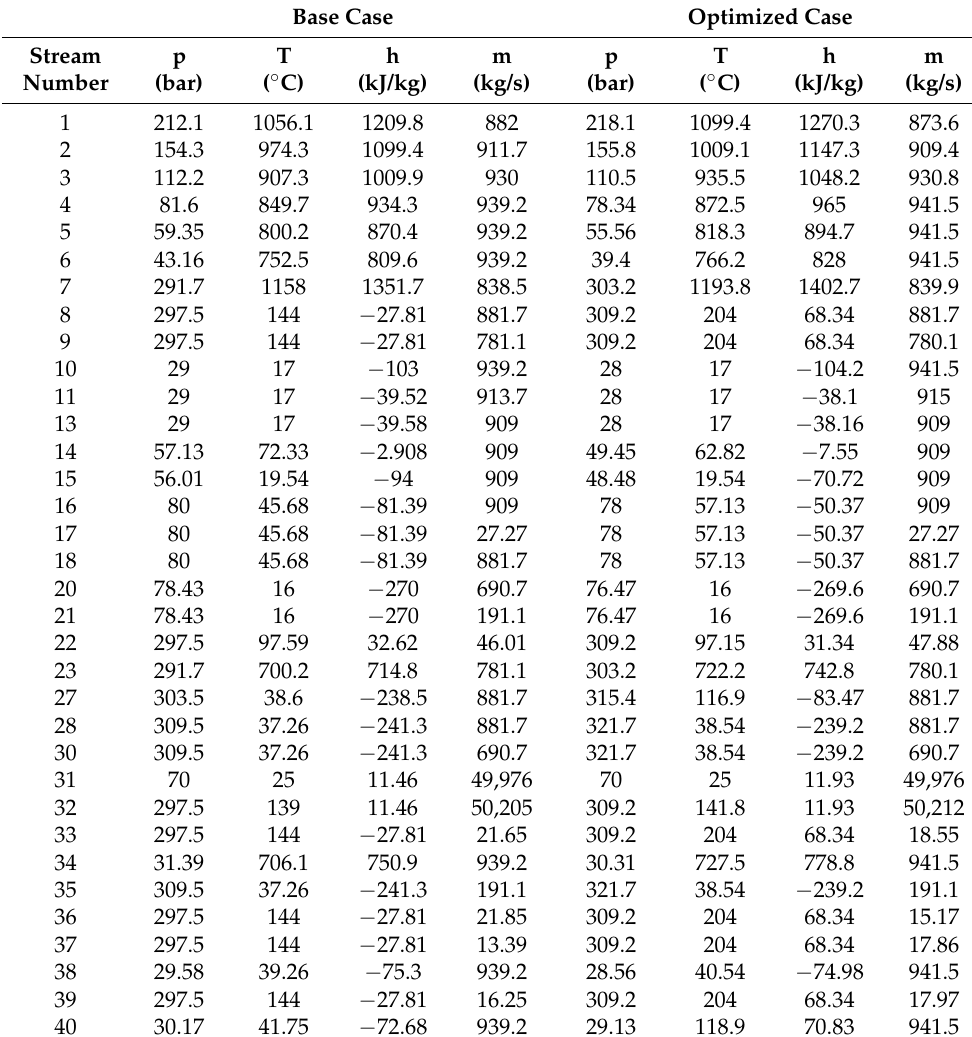
Table A2. Operating conditions related to stream numbers (see red and orange boxes) in Figure 2: base vs. optimized